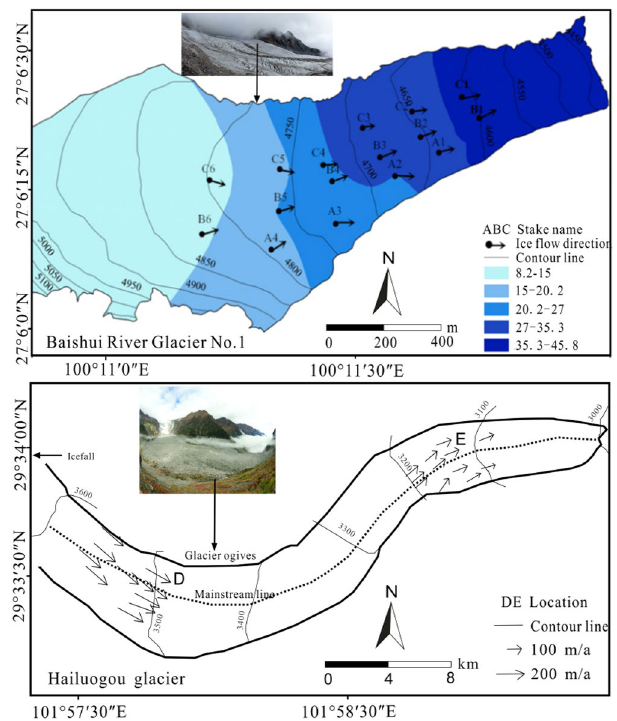
Figure 4. Spatial distribution for the surface flow velocity of the BRGN1 and